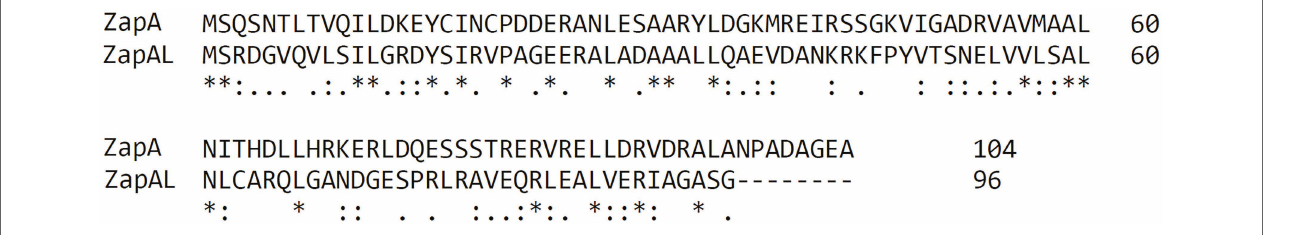
FIGURE 1 | Sequence comparison of ZapA and ZapA-Like protein (ZapAL) from P. aeruginosa using Clustal Omega. These two proteins share only 20% sequence identity and around 40% similarity.